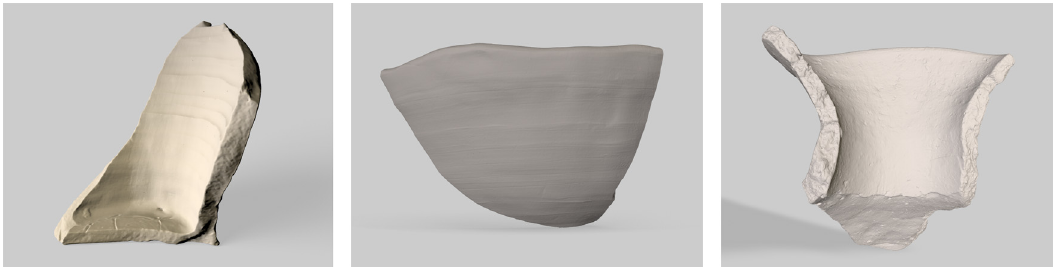
Figure 4: Acquiring skill. One of the fi rst scans with the DAVID SLS - 3, and one of the most recent, with more details visible. Image by the